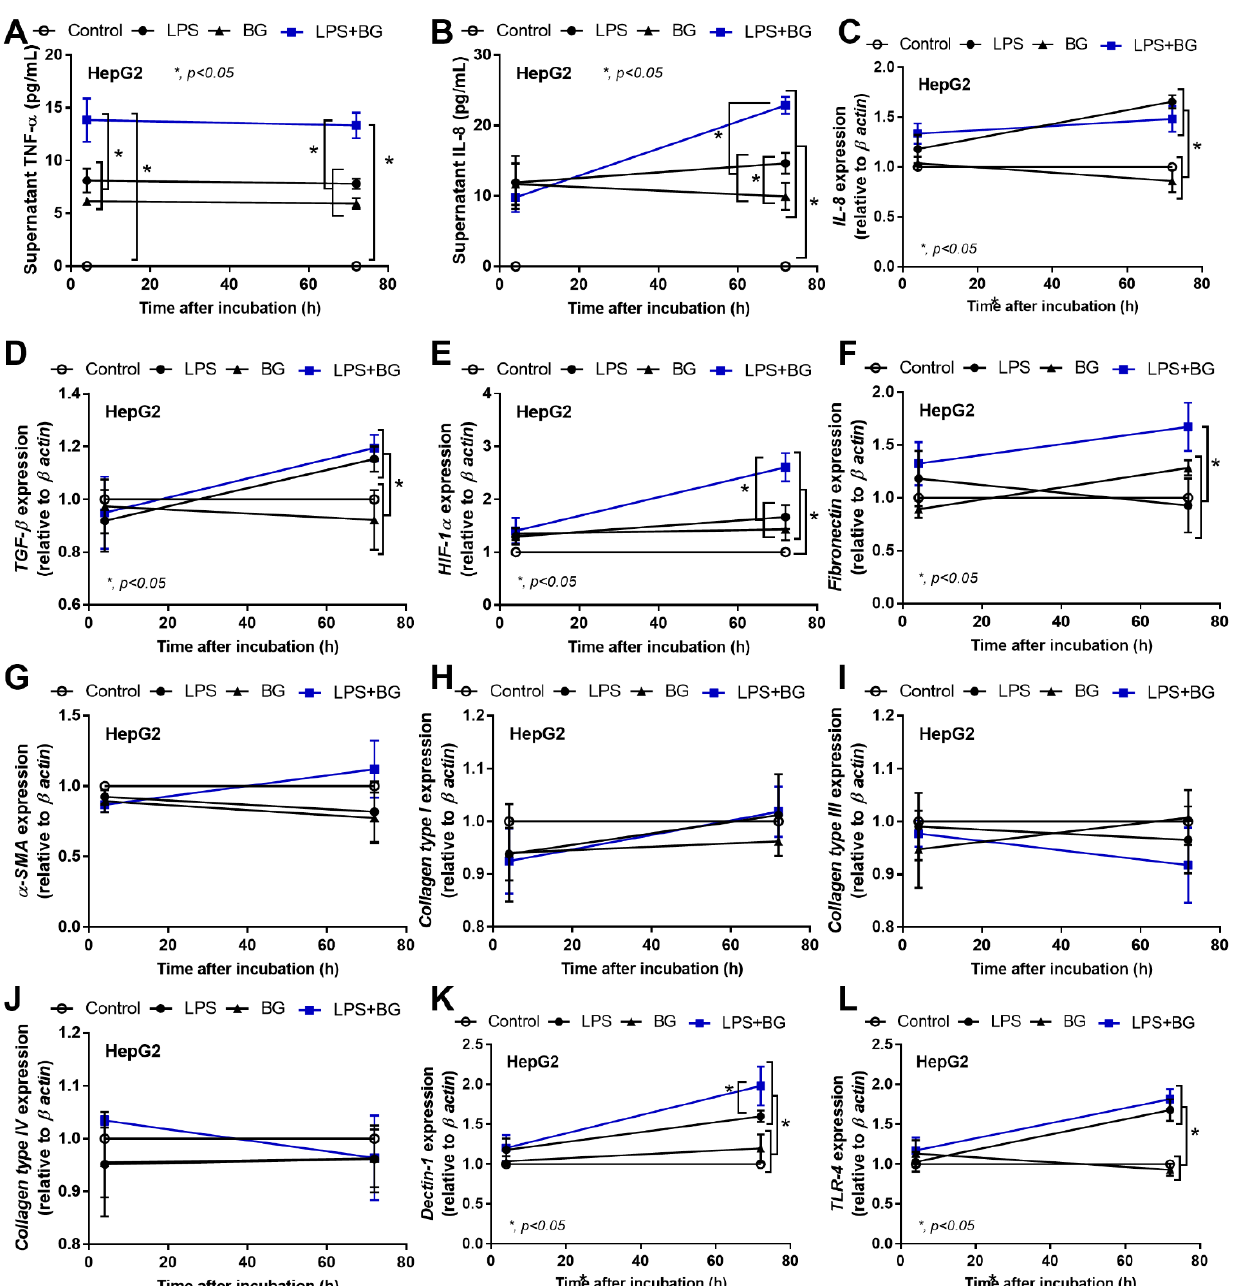
Figure 7. The characteristics of hepatocyte (HepG2 cells) after 1 and 72 h incubation in the culture medium (Control) or lipopolysaccharide (LPS) with or without (1 → 3)-B-D-glucan (BG), as indicated by supernatant cytokines (TNF- α and IL-8) ( A , B ), and the gene expression of cytokines (TGF- β and IL-8) ( C , D ), hypoxia-inducible factor-1 α (HIF-1 α ) ( E ), fibrosis-associated genes, including fibronectin, alpha-smooth muscle actin ( α -SMA), collagen (type I, III and IV) ( F – J ), and inflammatory mediators (Dectin-1 and Toll-like-receptor 4; TLR-4) ( K , L ) are demonstrated. Independent triplicate experiments were performed for all in vitro experiments.